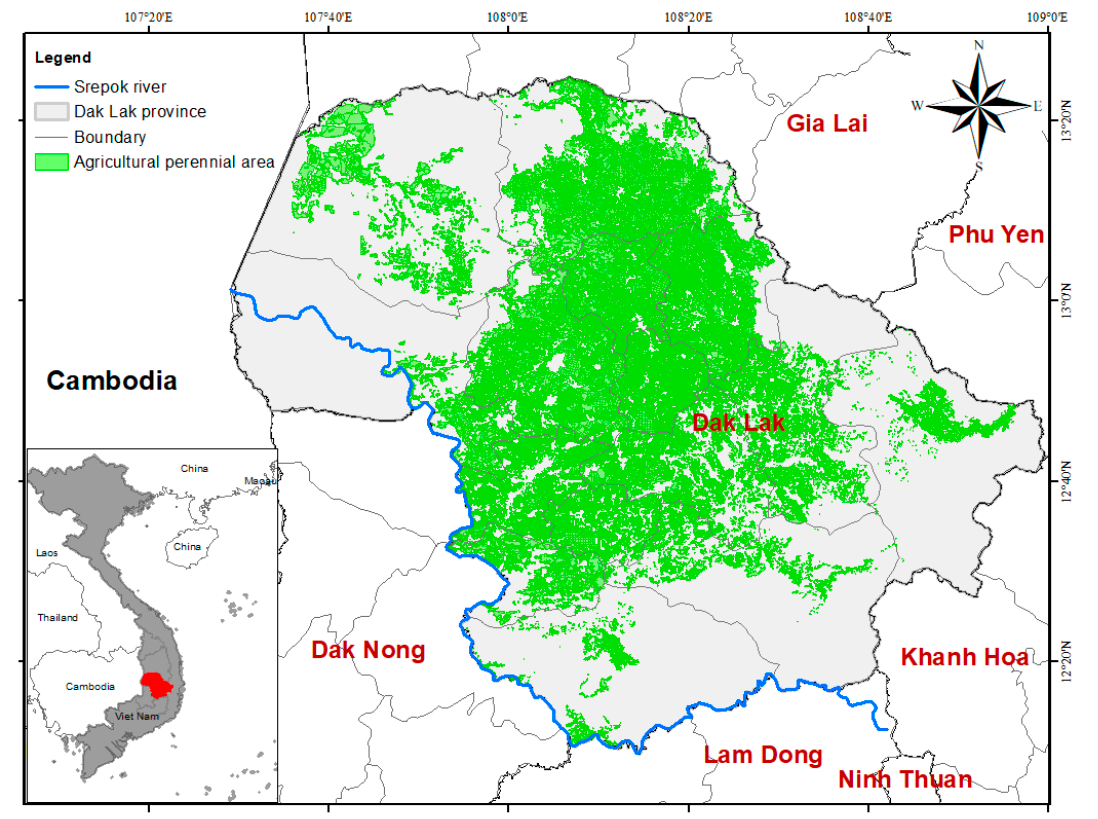
Figure 1. Dak Lak province with the agricultural perennial planted area indicated in green. The proposed methodology is based on multiple linear regression modeling using, on the one hand, the official coffee yields of Dak Lak province and, on the other hand, phenological variables derived from the seasonal dynamics of the satellite-derived biophysical variables NDVI (normalized difference vegetation index), LAI (leaf area index), and FAPAR (fraction of absorbed photosynthetically active radiation).